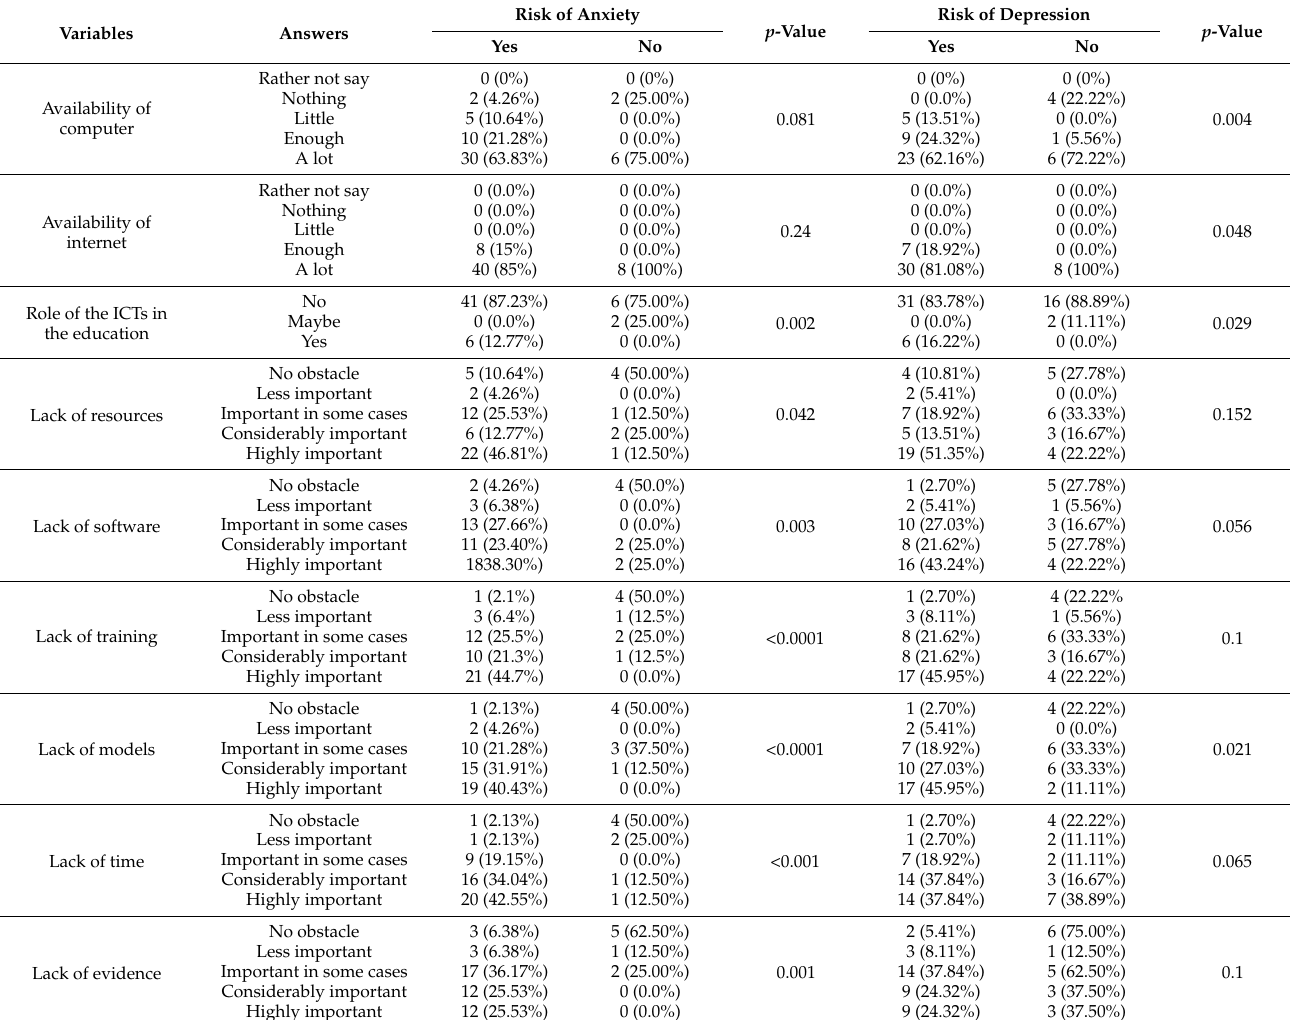
Table 4. Variables that indicated significant differences for the risk of anxiety and